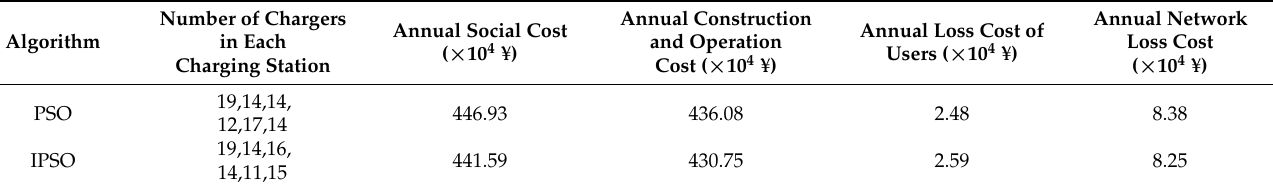
Figure 5. Charging stations’ locations and their service areas obtained by PSO and Voronoi diagram. Table 2. Comparison of simulation